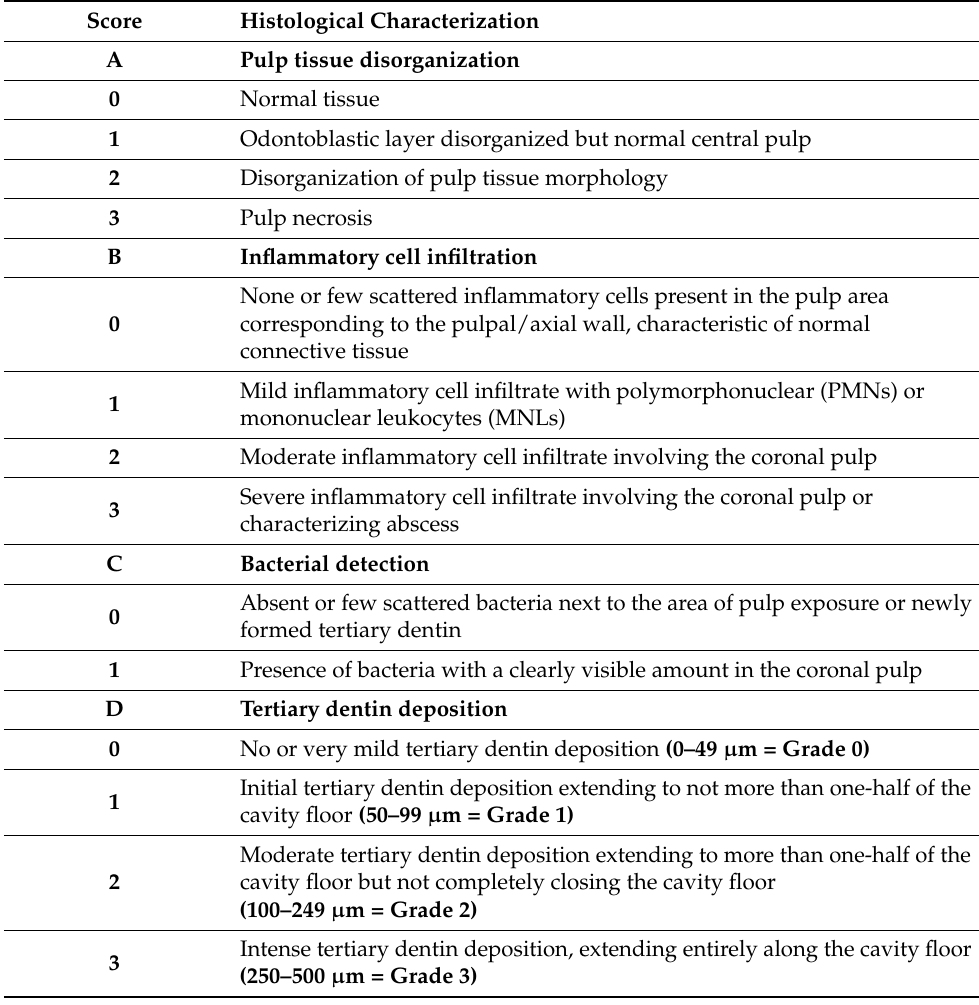
Table 1. Criteria for scoring of dentin-pulp complex response after occlusal and cervical restorations modified from Li et al. [27] and Costa et al.